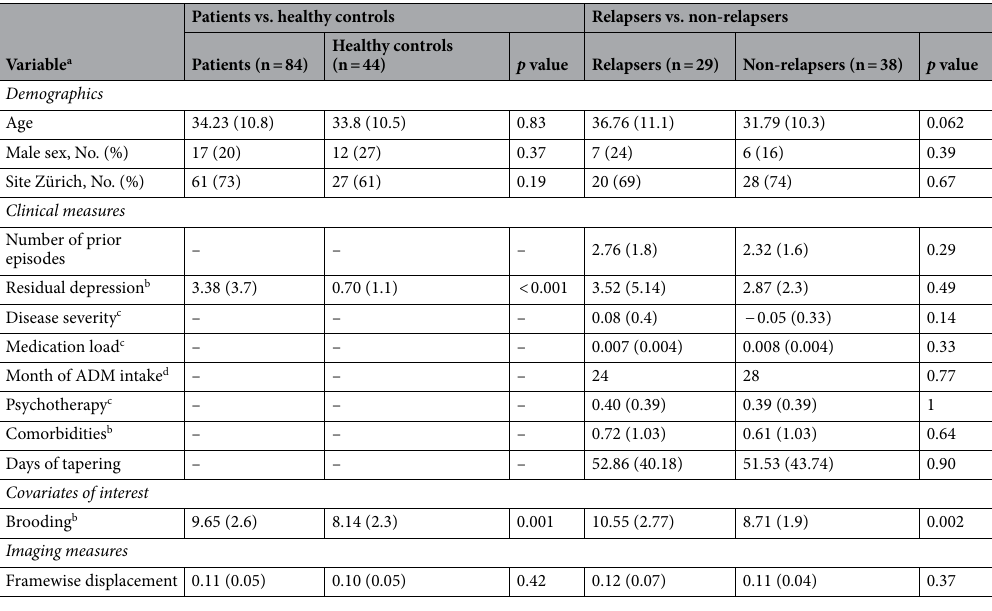
Table 1. Participant characteristics. a Unless stated otherwise, mean (SD) are shown. b Determined as follows: residual depression: Inventory of Depressive Symptomatology-Clinician Rated 45 ; brooding: brooding subscale of the German version of the Response Style Questionnaire 46 ; comorbidities: number of past and present psychiatric diagnoses. c Computation of the variables is described in the supplementary section S1.3. d Median is provided and a non-parametric Wilcoxon rank sum test was applied to test